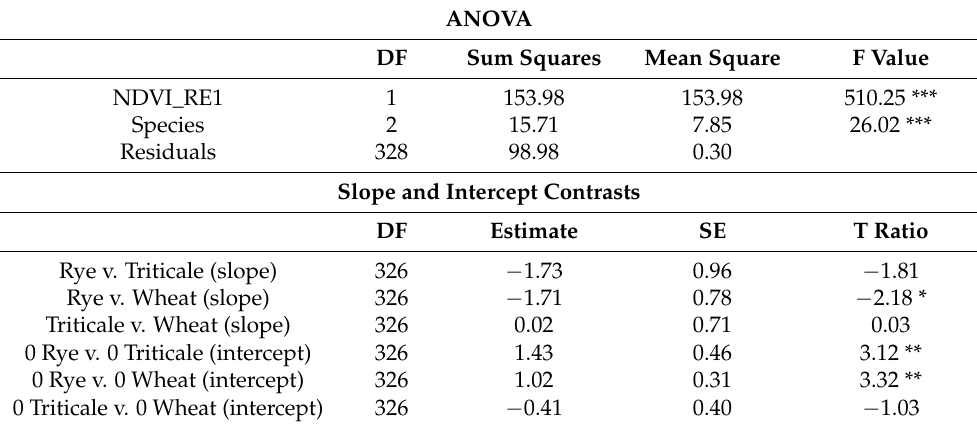
Table A2. Species contrasts in spring.